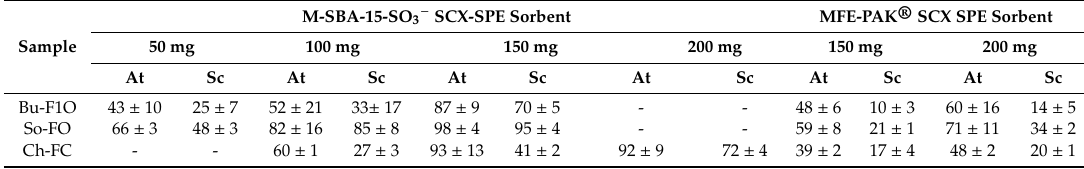
Table 3. Recovery percentages (% ± SD) for atropine (At) and scopolamine (Sc) obtained in buckwheat (Bu-F1O),sorghum(So-FO)andchickpea(Ch-FC)floursspikedwith0.1mLofa1mg / Lstandardsolution of atropine and scopolamine under di ff erent SLE-SPE conditions, using of sulfonic acid-functionalized SBA-15 and commercial materials as SCX-SPE sorbents